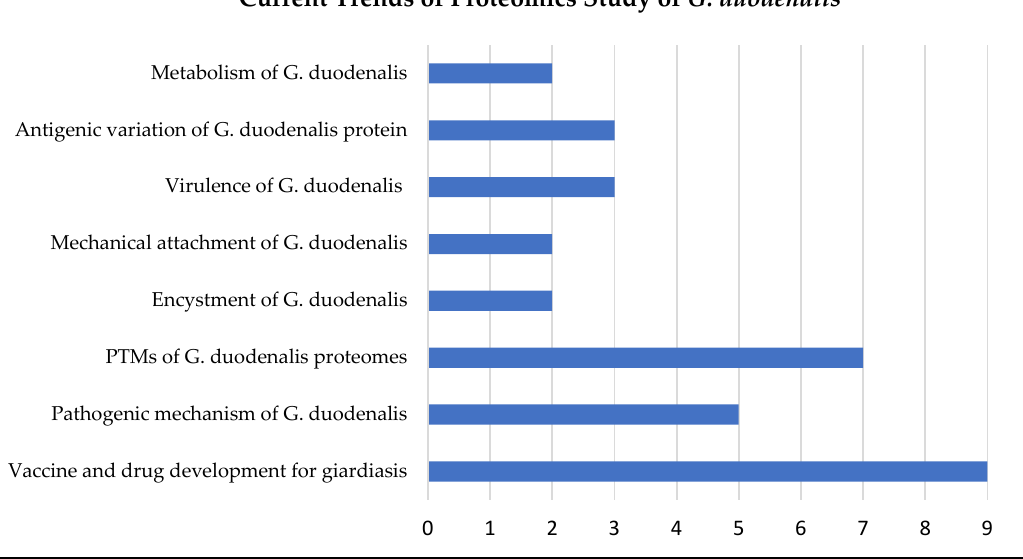
Figure 3. Current trends of proteomics studies on G. duodenalis . The numbers represent the number of studies focused on different areas of study from 2012 to 2022. The current proteomics studies on Giardia mainly focus on the development of vaccines and drugs for giardiasis, followed by the monitoring of the PTMs of Giardia